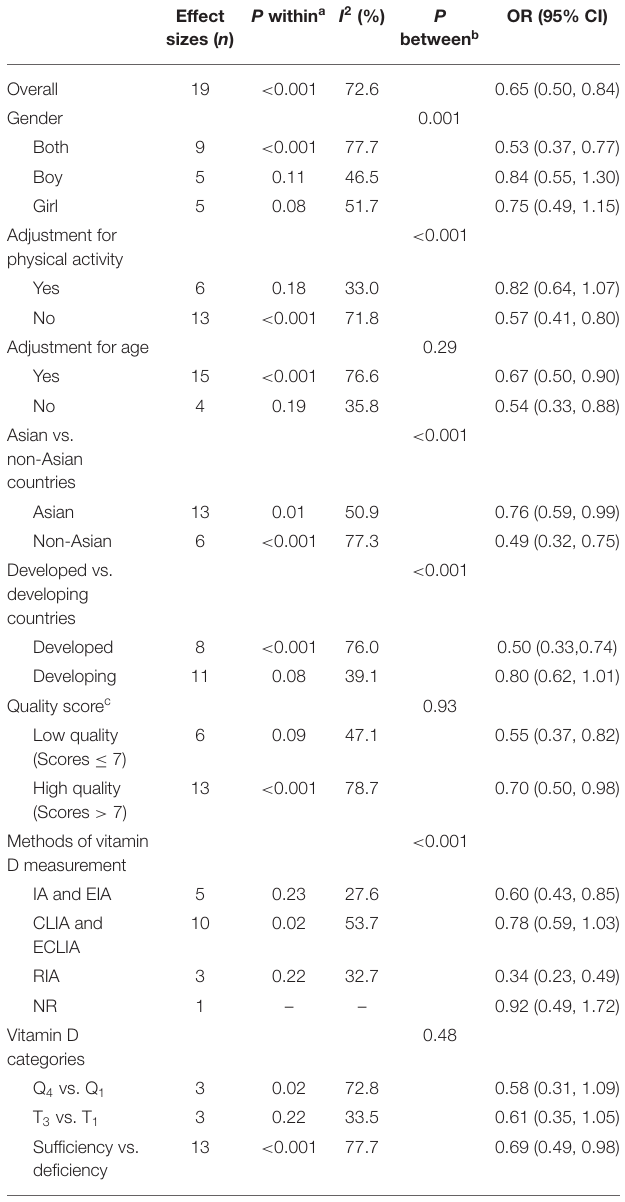
TABLE 3 | Results of subgroup analyses of serum vitamin D levels in relation to abdominal obesity in children and adolescent. P within a I 2 Effect sizes ( n )